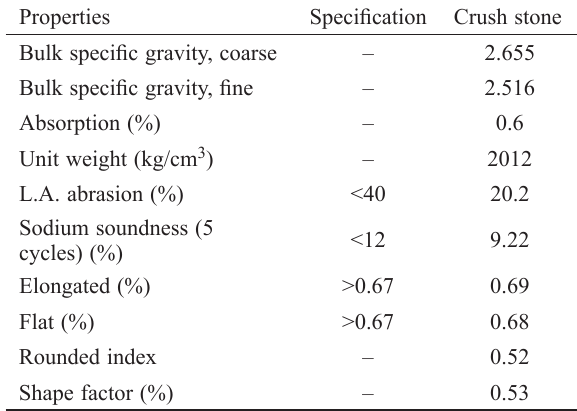
Table 2. Properties of aggregate